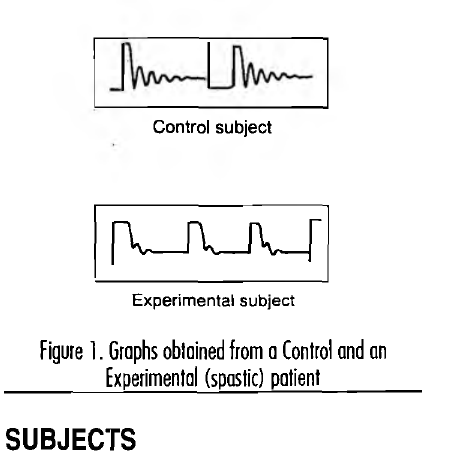
Figure 1. Graphs obtained from a Control and